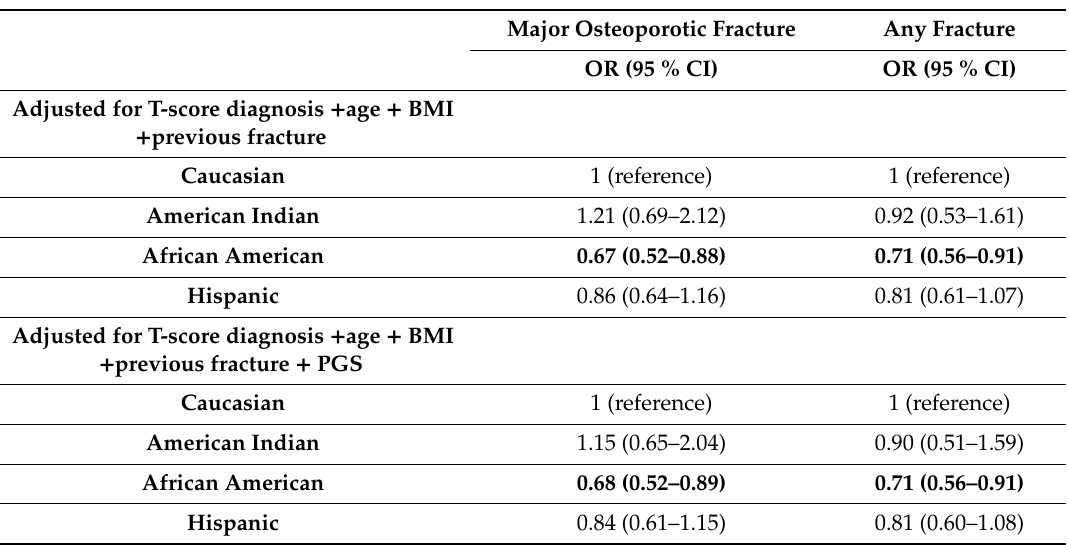
Table A2. Hazard Ratios (HR) with 95% Confidence Interval (CI) for Outcomes of Incidence Fracture According to Race Group, adjusted for T-score diagnosis, Age, BMI, Previous Fracture, and PGS Groups: Results from Cox Proportional Hazard Model.